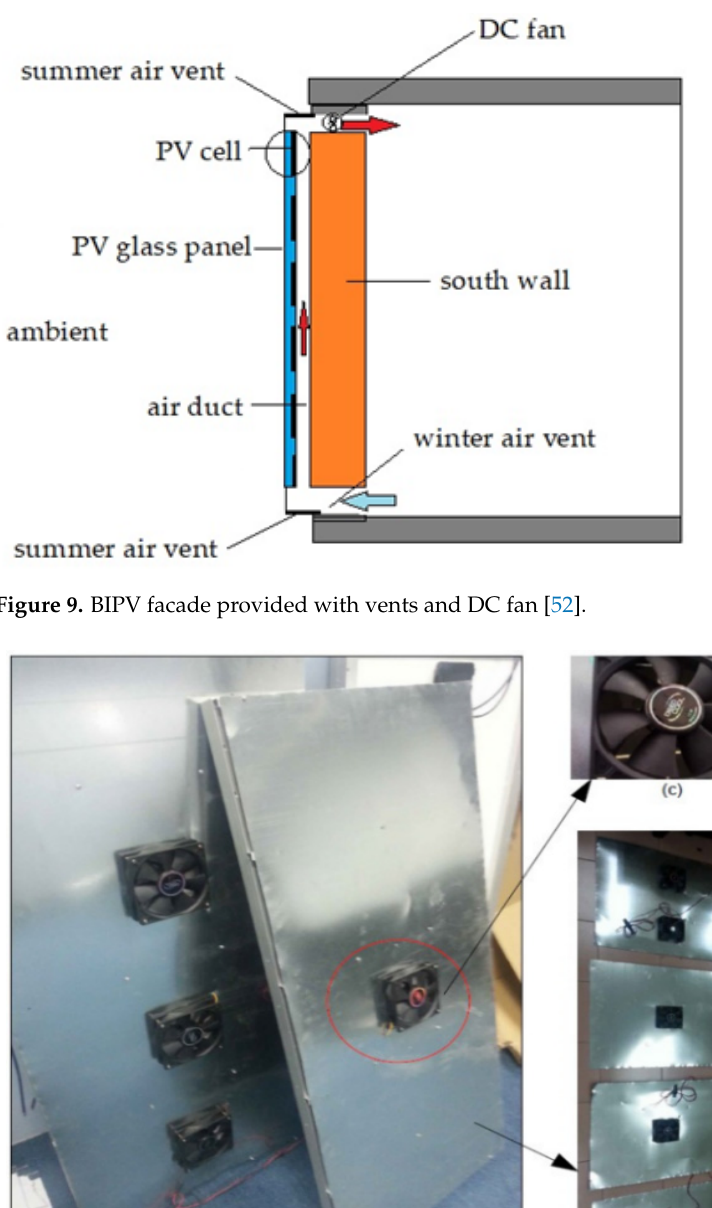
Figure 9. BIPV facade provided with vents and DC fan [52].